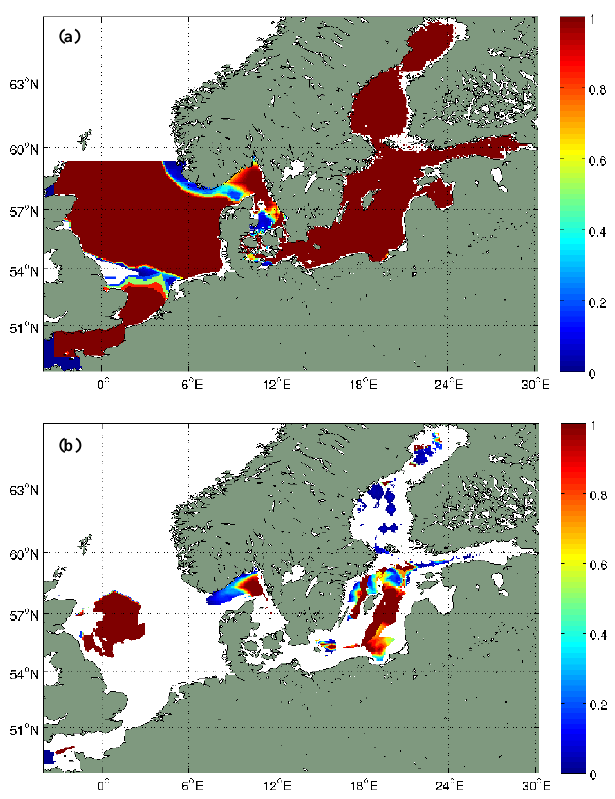
Fig. 9. Effective coverage rate at the depth of (a) 10m and (b) 75m for